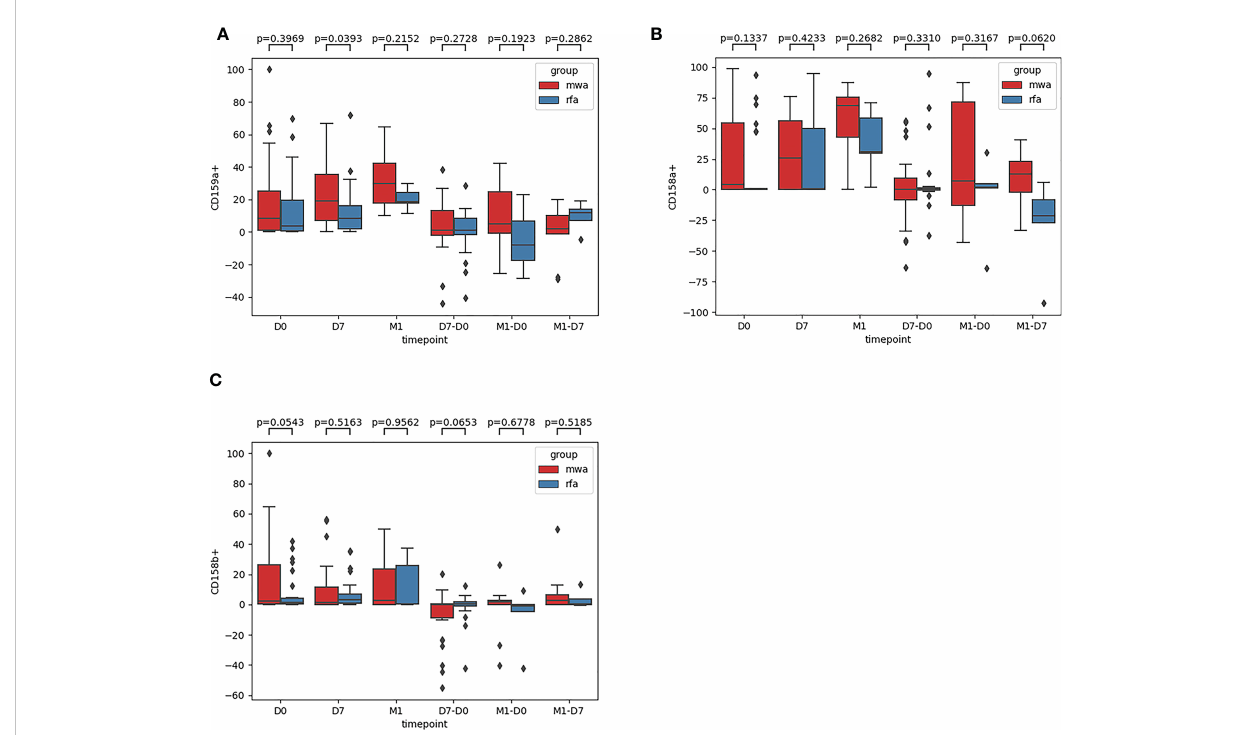
FIGURE 4 The frequencies of NK cell inhibitory receptors NKG2A [CD159A] (A) , CD158a (B) , CD158b (C) were compared between the RFA group and the MWA group. In D0(P=0.40,P= 0.13,P= 0.054), D7 (P= 0.04,P= 0.42,P=0.52), M1 (P = 0.22, P = 0.27, P = 0.96), D7 - D0 (P = 0.27, P = 0.33, P = 0.65), M1 - D0 (P = 0.19, P = 0.32, P = 0.68), M1, D7 (P = 0.29, P = 0.06, P = 0.52). The changes of NK cell inhibitory receptor CD159A(P<0.05) were signi fi cantly different between RFA group and MWA group one week after operation (A)